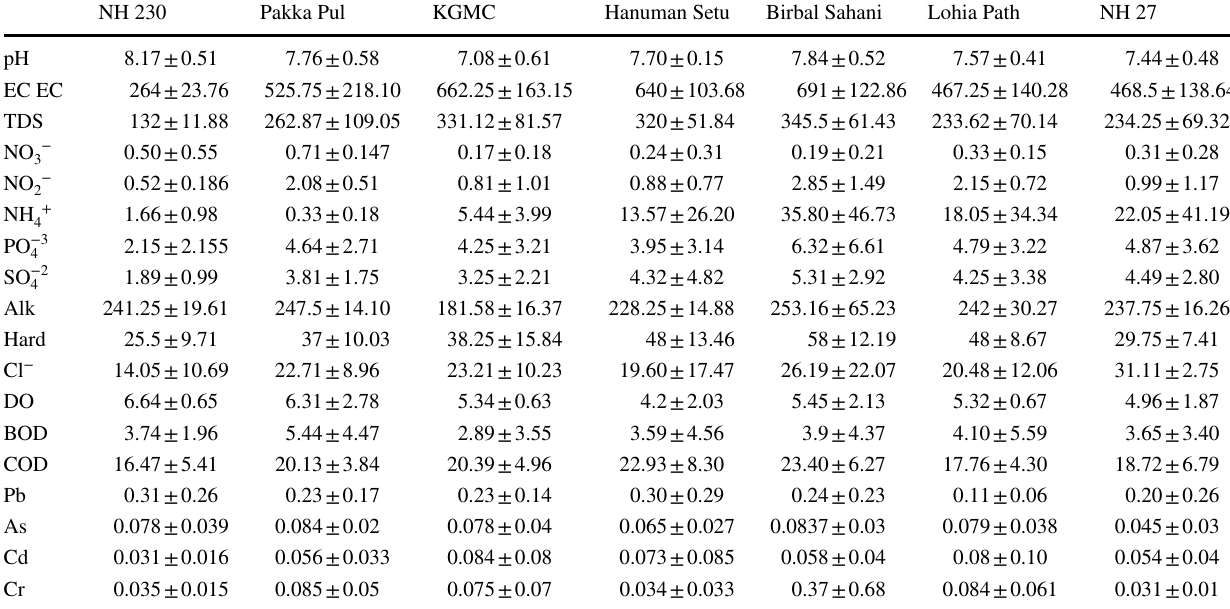
Table 2 Variation in physiochemical parameters of water at various sampling sites (Dutta et al.